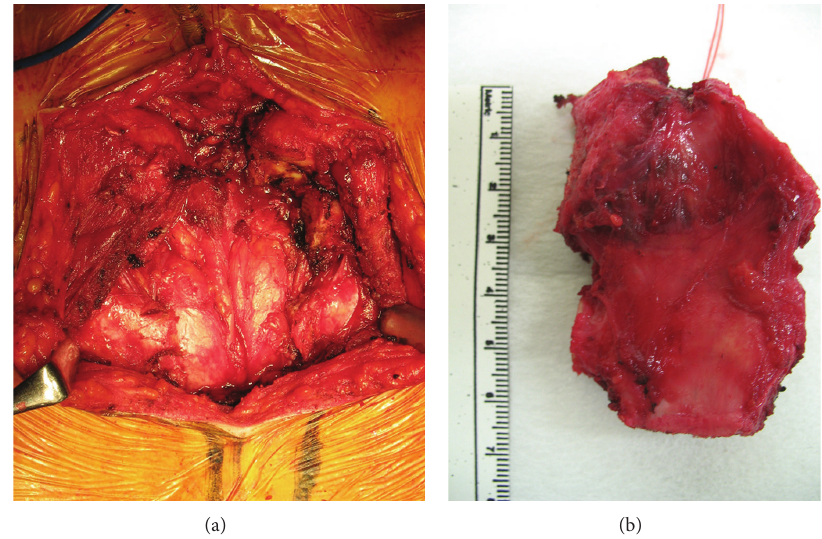
Figure 2: Intra-operative photography after resection of the sternal metastasis (a) and surgical specimen